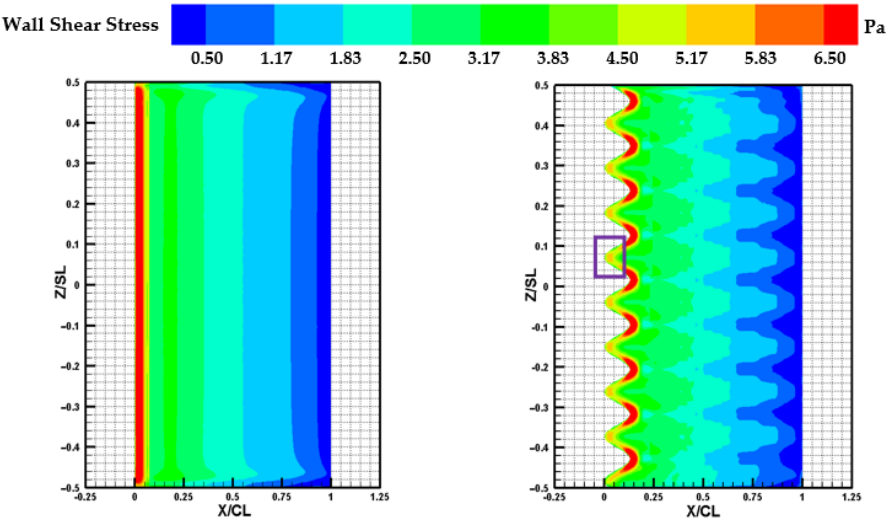
Figure 14. Comparison of the wall shear